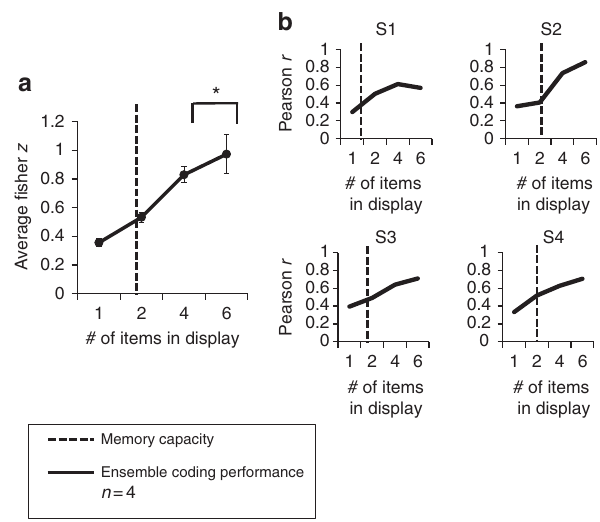
Figure 5 | Limited explicit memory of all items. ( a ) Observers perceived ensemble lifelikeness in the 250ms condition in Experiments 3 and 4 by integrating five or more objects (indicated by the significant difference in performance when four and six items are viewed). Separate memory capacity testing revealed that participants only recalled less than two items per display, on average (black dashed line). Error bars represent s.e.m.